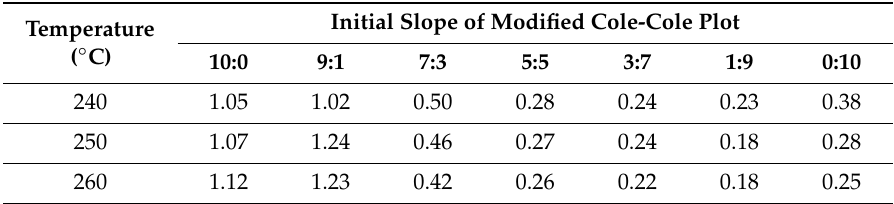
Figure 8. Initial slope of modified Cole-Cole plot at PC / ABS blend with increasing ABS content at given temperatures. Table 3. Initial slopes of modified Cole-Cole plot of PC / ABS